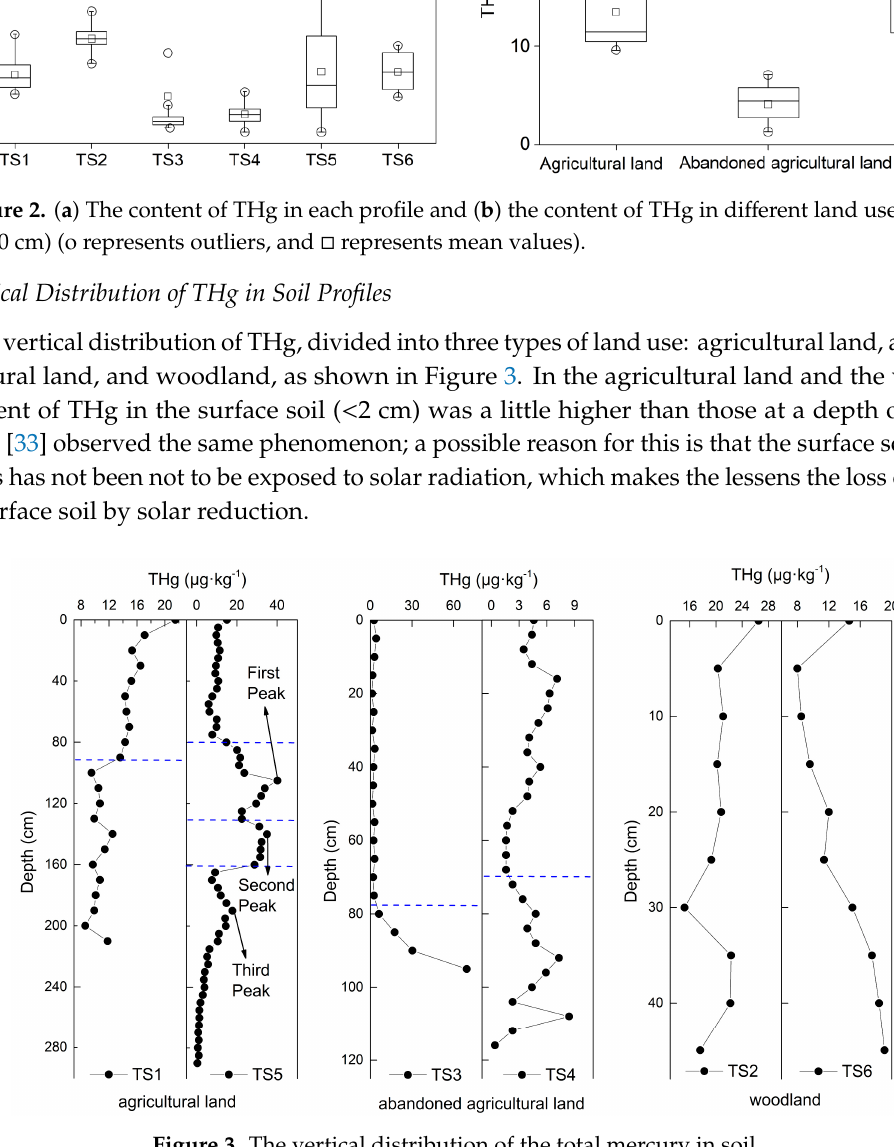
Figure 3. The vertical distribution of the total mercury in soil.